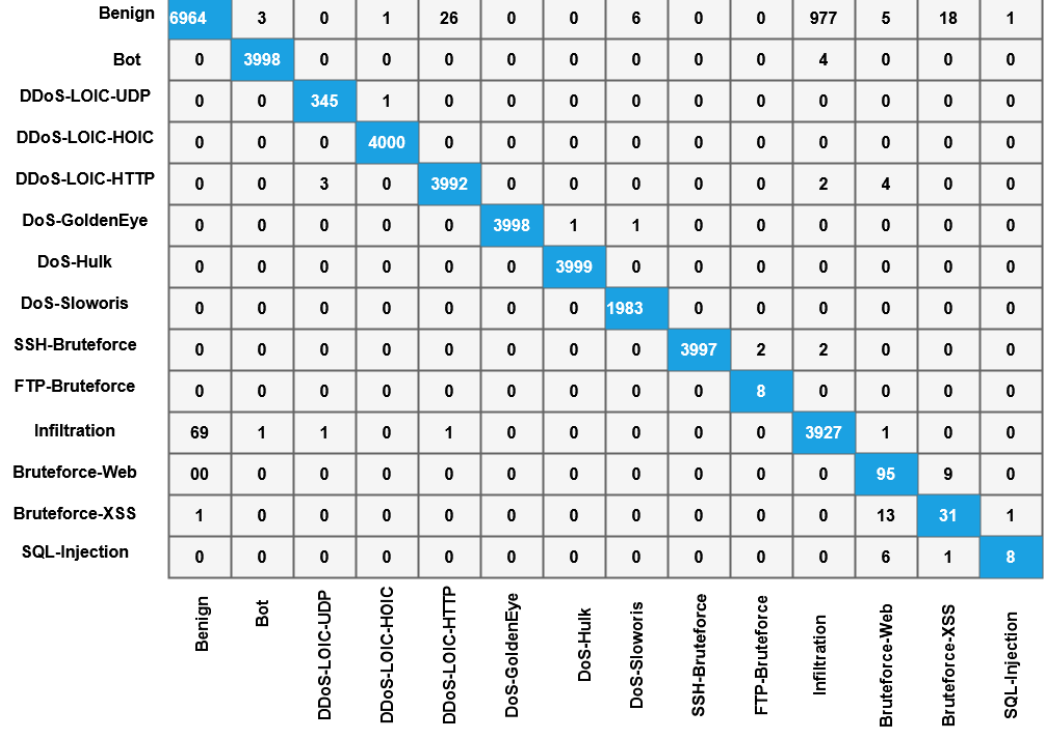
Figure 2. Confusion matrix for the CSE-CIC-IDS 2018 dataset.